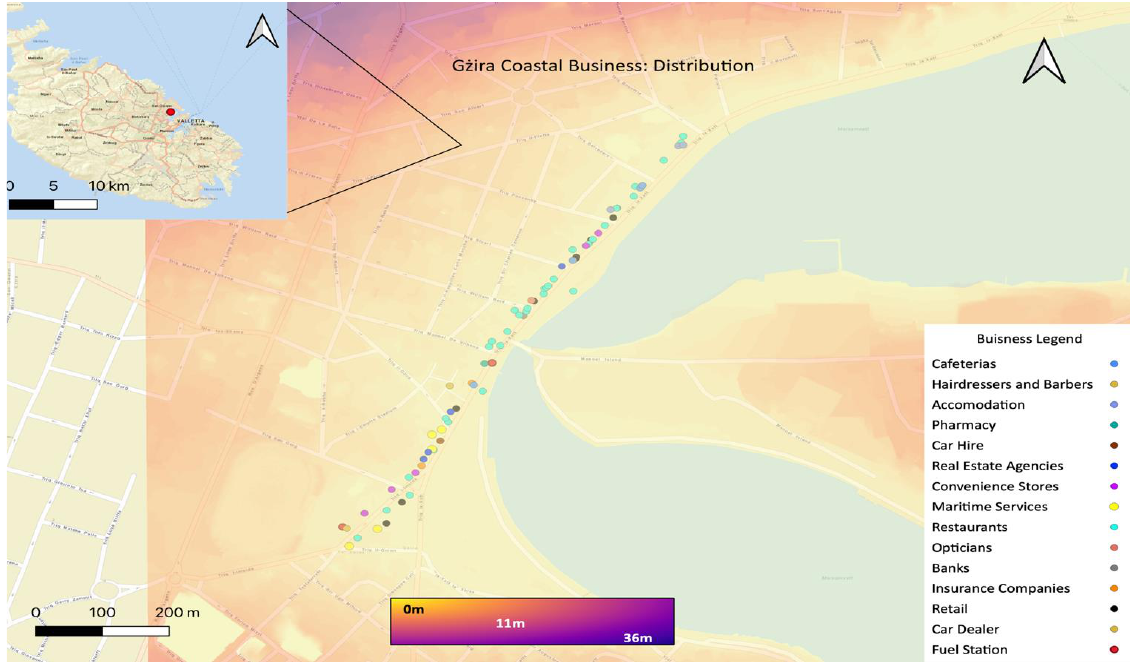
Figure 7. Gżira’s coastal businesses’ distribution.